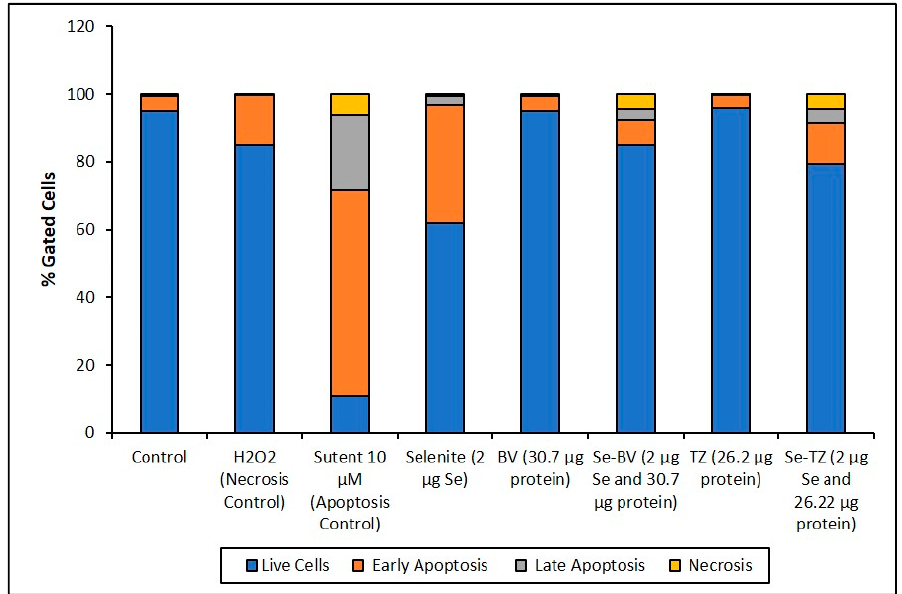
Figure 13. Cell representation (%) within the four quadrants for HME50-5E cell treatment. Percent distribution of HME50-5E apoptotic cells after treatment with H 2 O 2 , Sutent, Selenite as Se, Bevacizumab (BV), Selenobevacizumab (Se-BV), Trastuzumab (TZ) or Selenotrastuzumab (Se-TZ). Data is expressed as Mean ( n = 3).